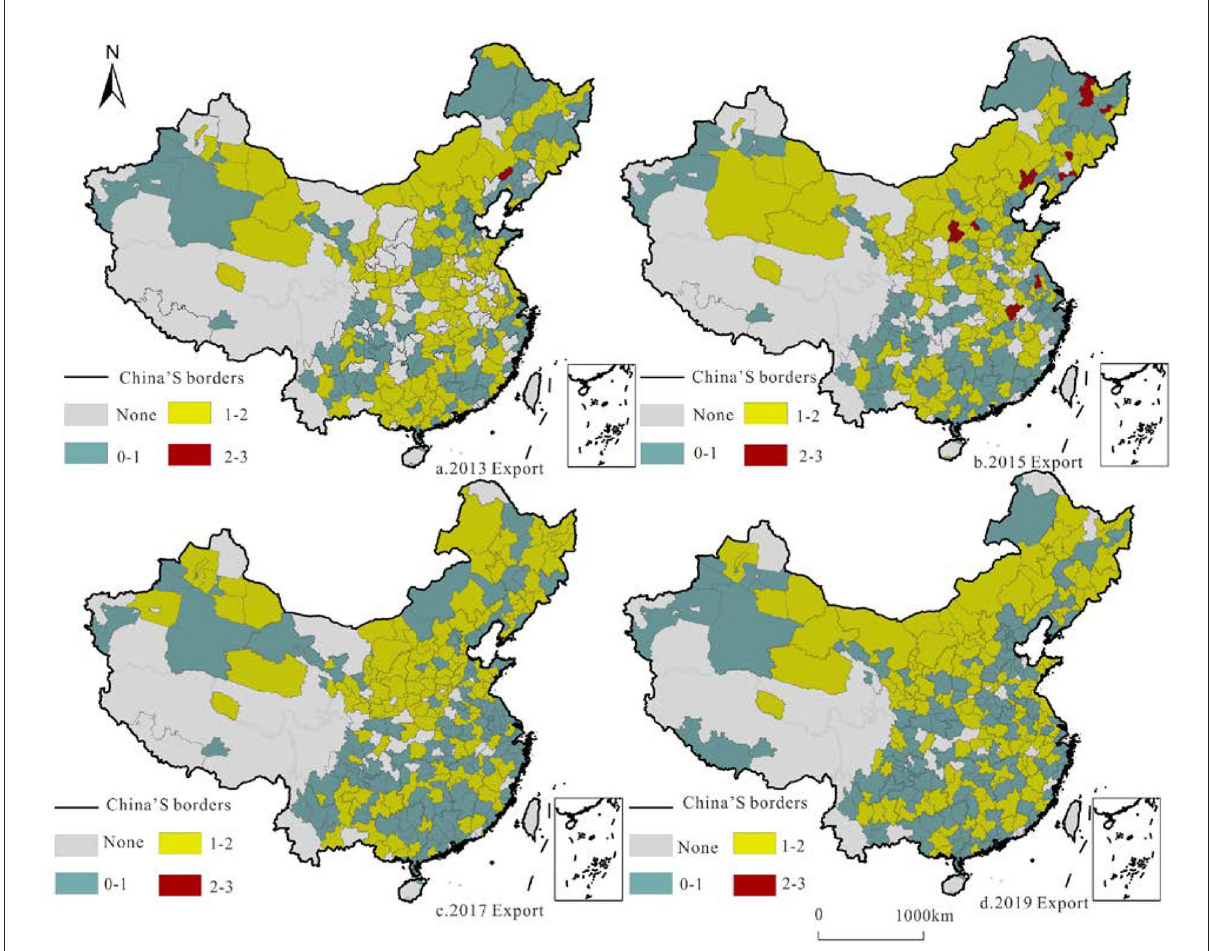
FIGURE9 Location quotient pattern and evolution of China’s railway container export volume in